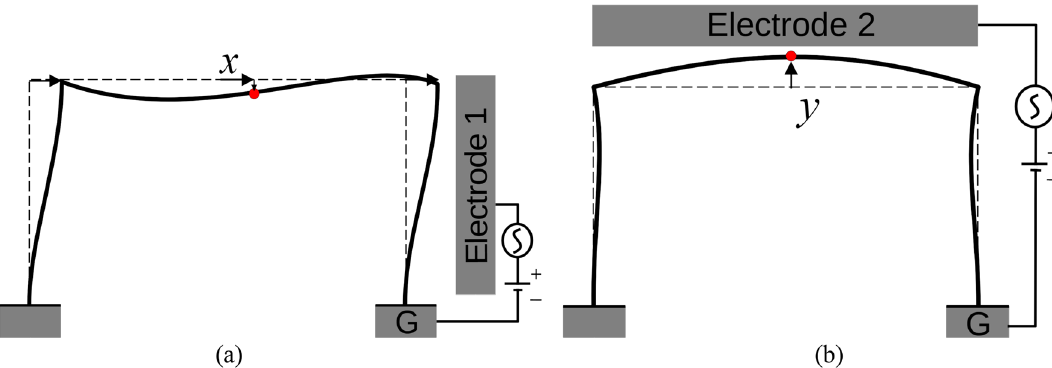
Figure 2. Schematic for ( a ) the 1st vibration mode under the actuation of E1, and ( b ) the 2nd vibration mode under the actuation of E2, of the micro portal frame model. Note that the 1st and 2nd modes are in the orthogonal direction, where the 1st mode motion is dominantly in the X-direction, while in the 2nd mode, the structure moves mainly in the Y-direction. The dashed line represents the microstructure at rest, and the generalized coordinates x and y set in the mid-span of the supported beam denote the motion at the position of the colored of E = 150GPa, the short beam elements of length L 1 = 145.2 µm, the long beam element (supported beam) of length L 2 = 221 µm, and the out-of-plane dimension of 25 µm. The beam and columns widths are respectively h 2 = 1.84 µm and h 1 = 1.8 µm. In addition, the distance between the supported beam and columns from their respective electrodes are d = 3.33 µm and g = 3.51 µm, respectively. These parameters are slightly different from the nominal values of the fabricated device (some with a 10% difference); however, they are within the range of measurement error and also correspond to Fig. 1. To yield simulated results, Eqs. (1) and (2) are integrated in time using the 4th order Runge–Kutta numerical method with the parameters of Table S1 calculated through the above-mentioned parameters. Experimental setup and characterization. The in-plane resonance frequencies are measured through the stroboscopic video microscopy of the Micro System Analyzer (MSA) from Polytec, Fig. 3, using a ring-down measurement. The camera’s targets are set on the end of a column, the square A, and in the mid-span of the sup- ported beam, the square B, as illustrated in Fig. 1b, to measure the response of the 1st and 2nd modes, respec- tively. Square A is set to measure the displacement of the supported beam in the X-direction, while square B is set to measure the displacement of the structure in the Y-direction. Due to the small gap between the resonator and the electrodes, a vacuum chamber is required to minimize the squeeze-film damping 12 , with a pressure of 250mTorr set throughout the experiments. The frequency responses curves, forced vibration responses, are obtained using the stroboscopic video micros- copy with a Bode plot of the Planar Motion Analyzer (PMA) software of the MSA. The first and second resonance frequencies are measured as 76.076 kHz and 166.710 kHz, respectively. The